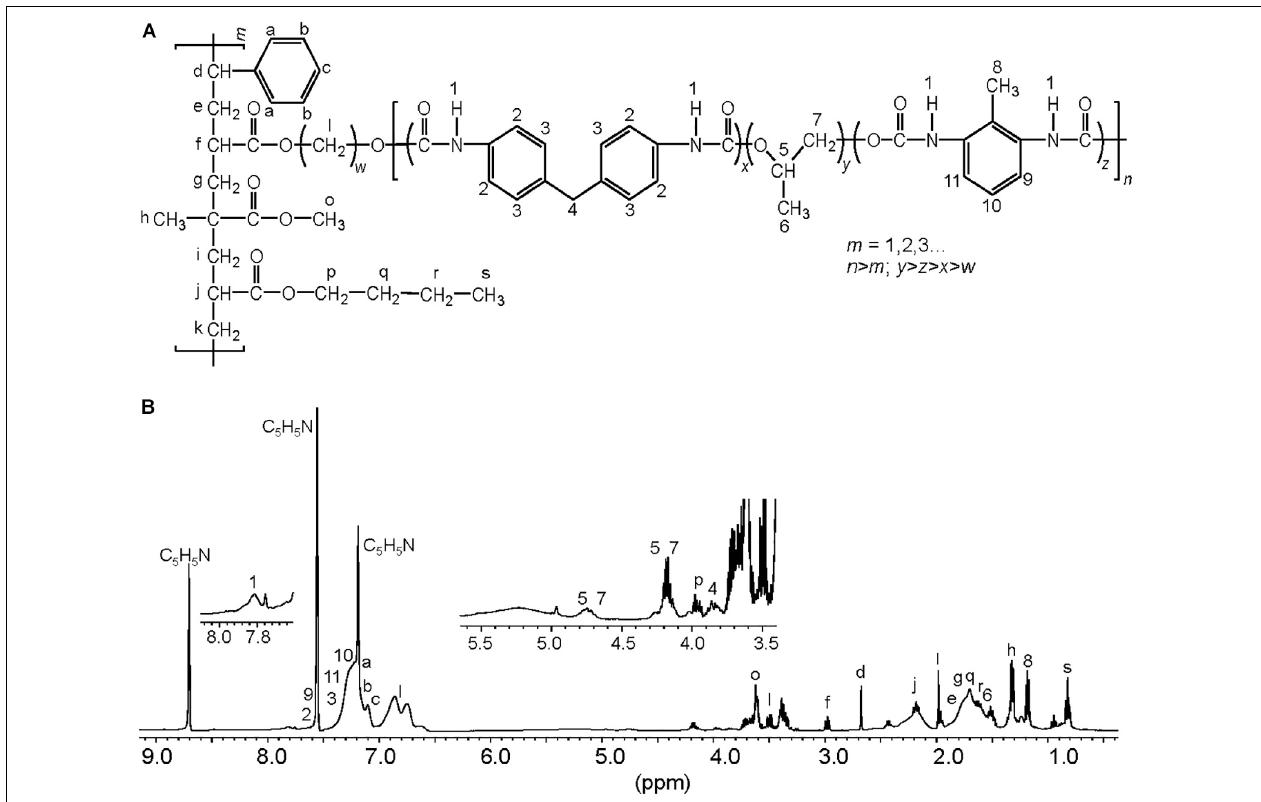
FIGURE 3 | Proposed chemical structure for the PE-PU-A copolymer present in PolyLack R (cid:13) . (A) This structure was proposed based on the (B) 1 H-NMR analysis of dried PolyLack R (cid:13) , the information included in the manufacturer technical manual (SayerLack. Poly Lack Aqua Brillante UB-0800), the GC-MS analysis ( Figure 2 ), and the most frequent acrylates used in the synthesis of these types of copolymers (Pardini and Amalvy, 2008; Maurya et al., 2018). Synthesis of PE-PU-A copolymers starts by the polycondensation of polyols [polypropylene glycol (PPG)] (y moiety) and diisocyanates (TDI and MDI) (x and z moieties) followed by end capping with acrylates’ mixture (m moiety). From the most frequently used acrylates we selected methyl methacrylate, butyl acrylate, hydroxy acrylate and styrene as representatives in this structure. In the 1 H-NMR spectrum, chemical shifts are provided in parts per million from SiMe 4 as internal reference. Signal 1 is assigned to carbamate groups (NH-COO); signals a, b, c, 2, 3, 9-11 are assigned to the aromatic protons; signals 4 and 8 correspond to the protons of methylene (CH 2 ) and methyl (CH 3 ) groups in MDI and TDI, respectively; signals 5–7 correspond to PPG; signals l correspond to the hydroxyl proton (CH 2 -O) and methylene groups (CH 2 ) in the chain of hydroxy-acrylate; signals f, j, o and p correspond to the acrylic groups (CH-COO, CH 2 -COO or CH 3 -COO), signals d (CH), e, g, i, k, q, r (CH 2 ), h and s (CH 3 ) are assigned to methylene and methyl groups in the acrylate